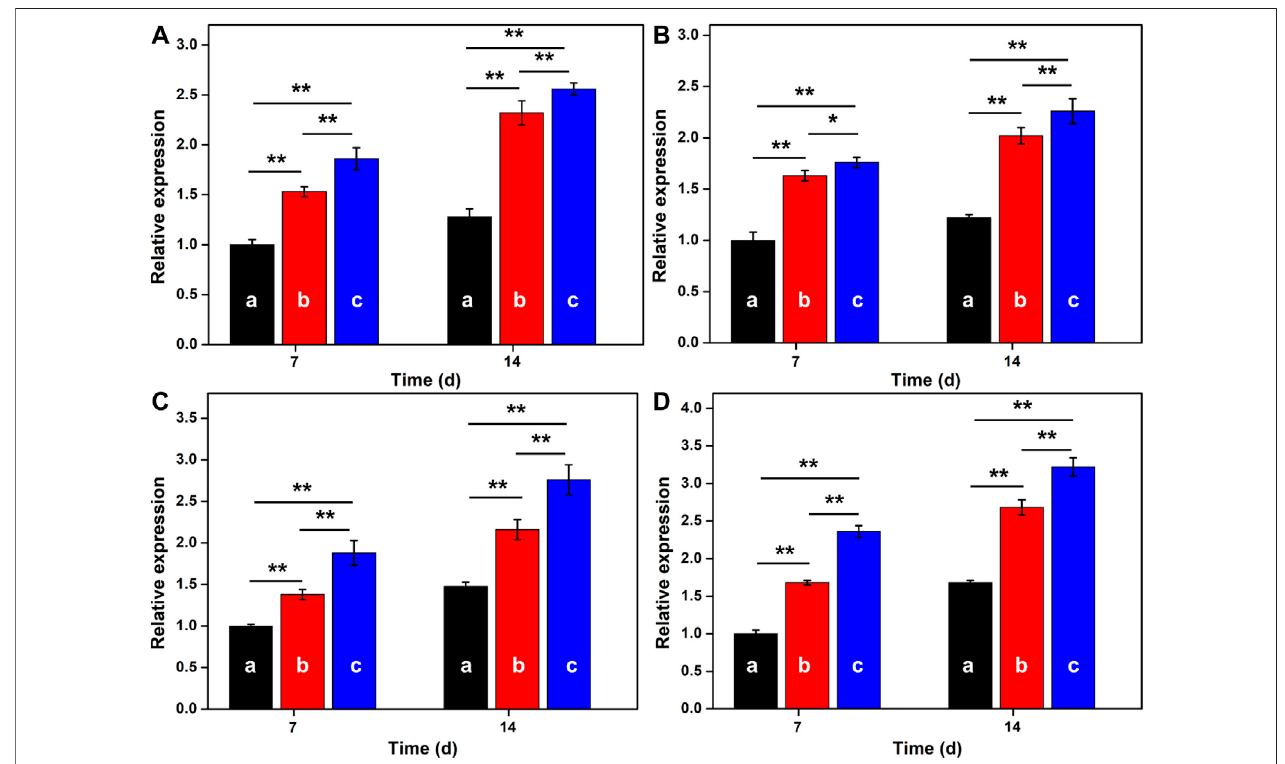
FIGURE 5 | RT-PCR analysis. The mRNA expression of cartilage-speci fi c marker genes of (A) ACAN, (B) COL-2, (C) PRG4, and (D) SOX-9 for (A) GelMA, (B) GelMA-CS, and (C) GelMA-CS@KGN (100 μ g/ml) scaffolds determined by RT-PCR tests on days 7 and 14 ( n = 3, * p < 0.05, and ** p < 0.01).